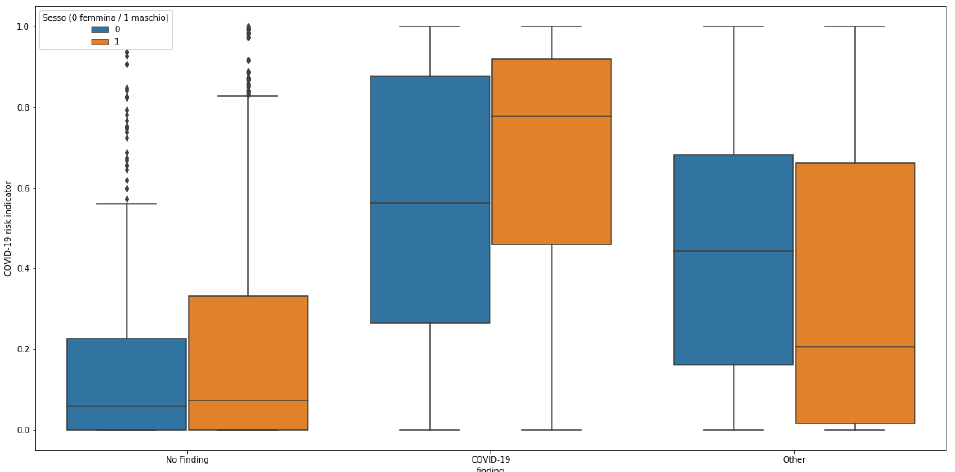
Figure 8. Distribution of the predicted COVID-19 risk indicator for cases belonging to the three clas- ses.